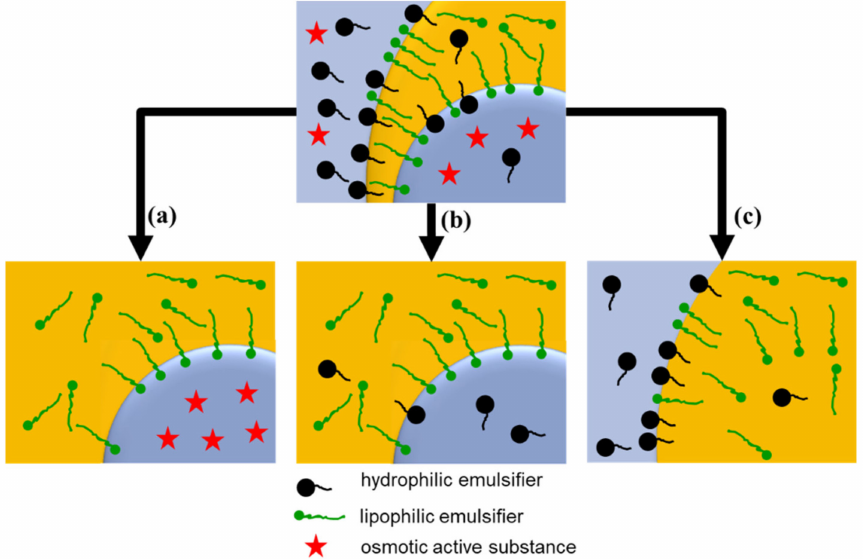
Figure 10. Possible simplifications of a double emulsion to measure instability mechanisms. Simplifications to investigate the inner emulsion ( a , b ), and the outer emulsion ( c ). Models proposed by Neumann et al.